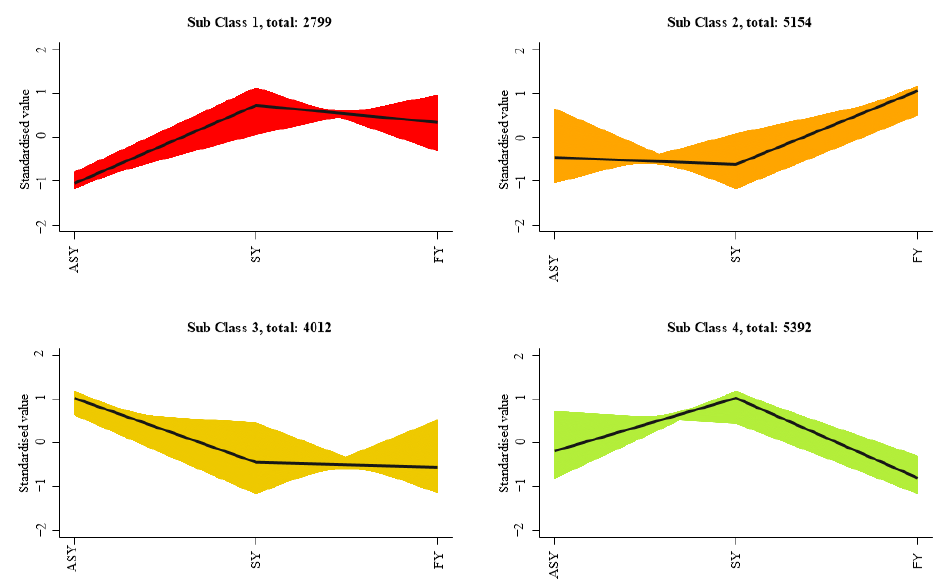
Figure 8. The K-mean classification analysis of gene expression in F. cirrhosa . SY: six-year samples. ASY: aberrant six-year samples. FY: four-year samples.